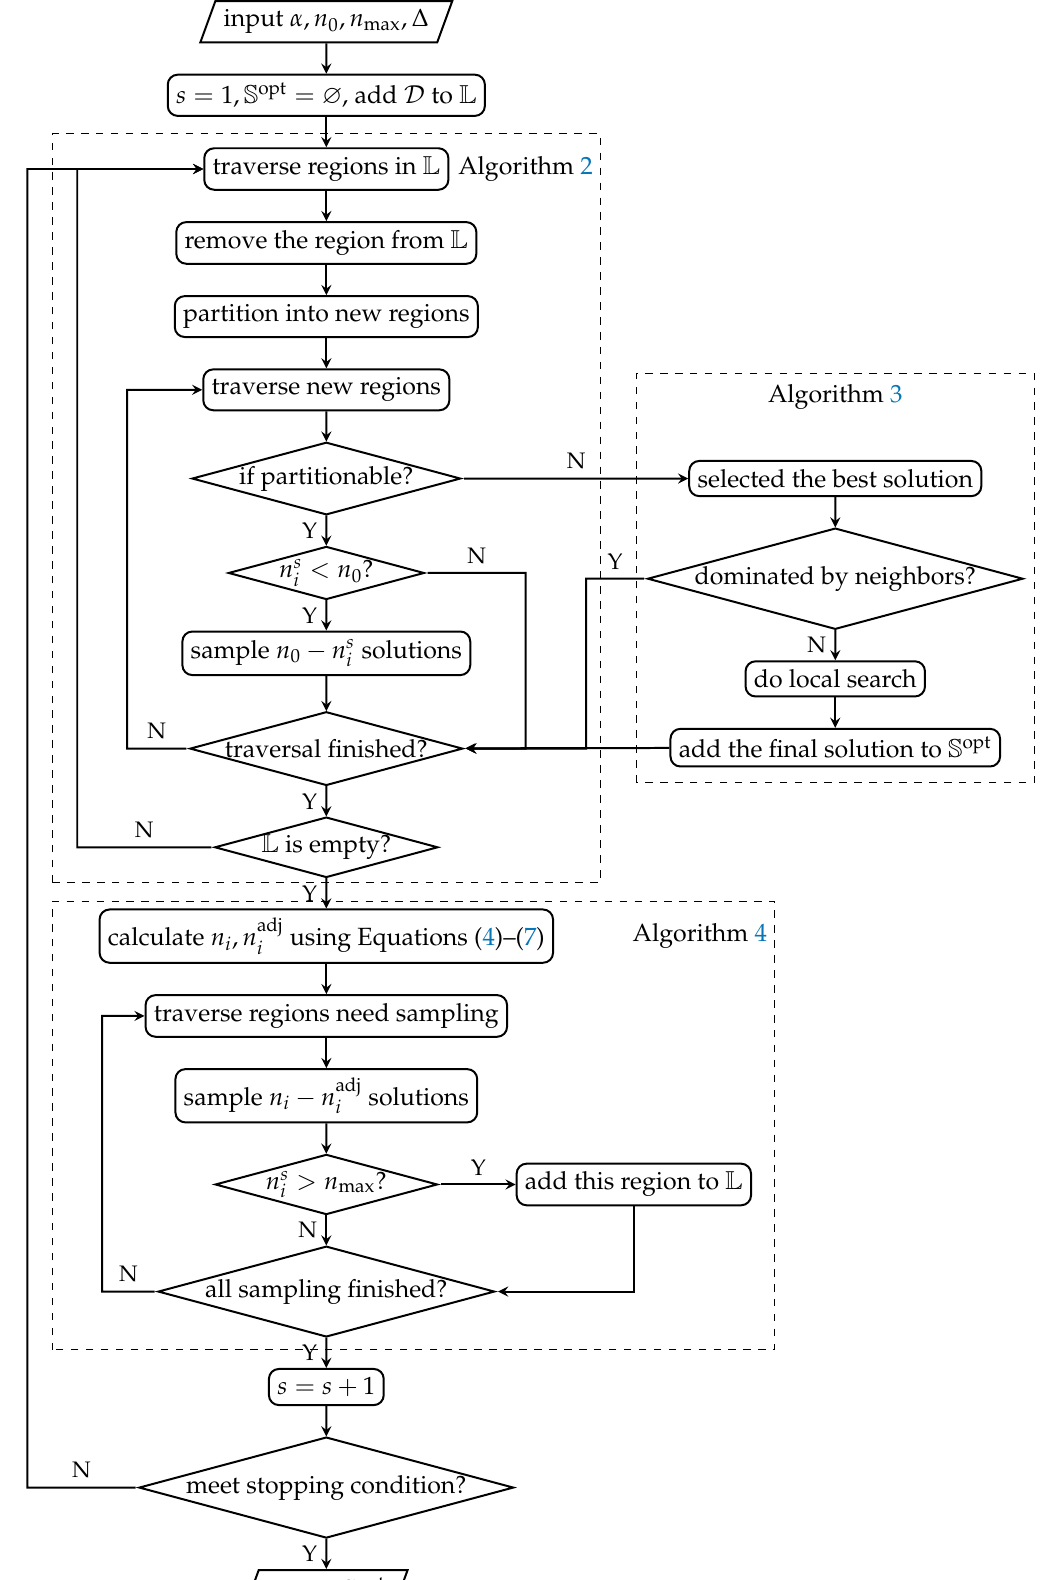
Figure 1. The flow chart of the proposed algorithm (Algorithm